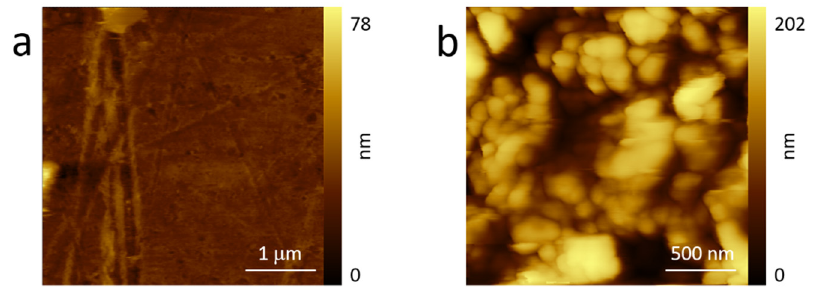
Figure 3. AFM images of the pristine Kapton ( a ) and after laser burning ( b ) acquired in air. See the text for more details.